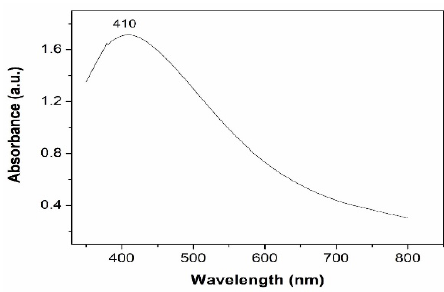
Figure 5. UV–visible absorption spectrum of as ‐ prepared Ag nanoparticles.